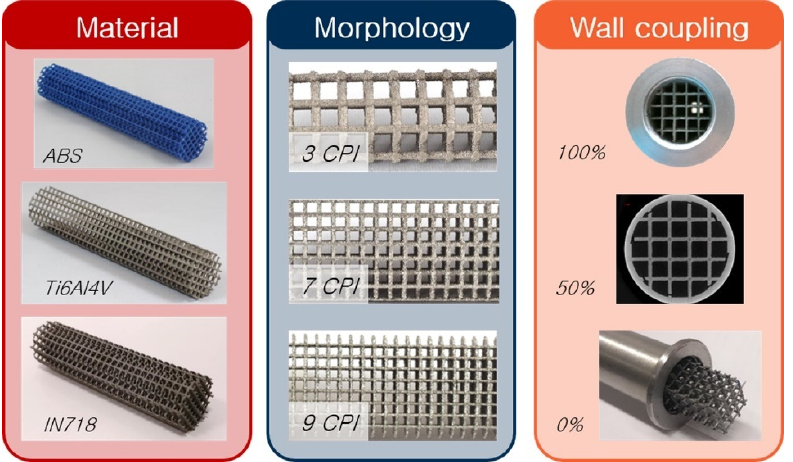
Figure 5. Periodic open cellular structures (POCS) made of different materials, with varying wall coupling and morphologies. Adapted from reference [68].